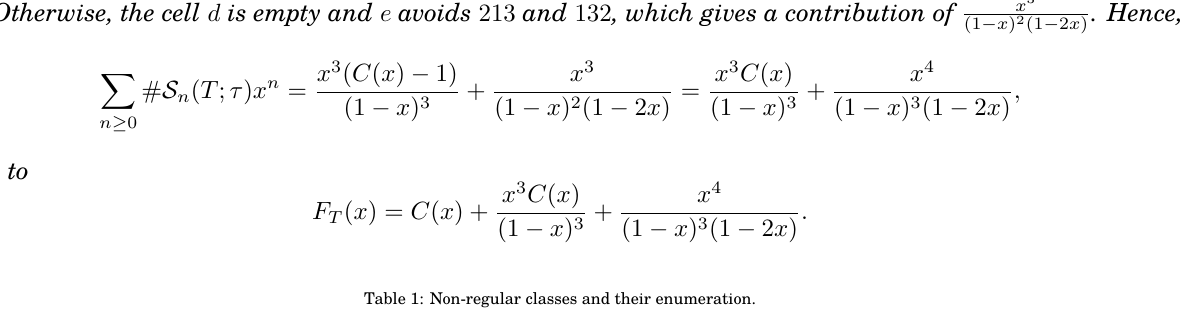
Table 1: Non-regular classes and their